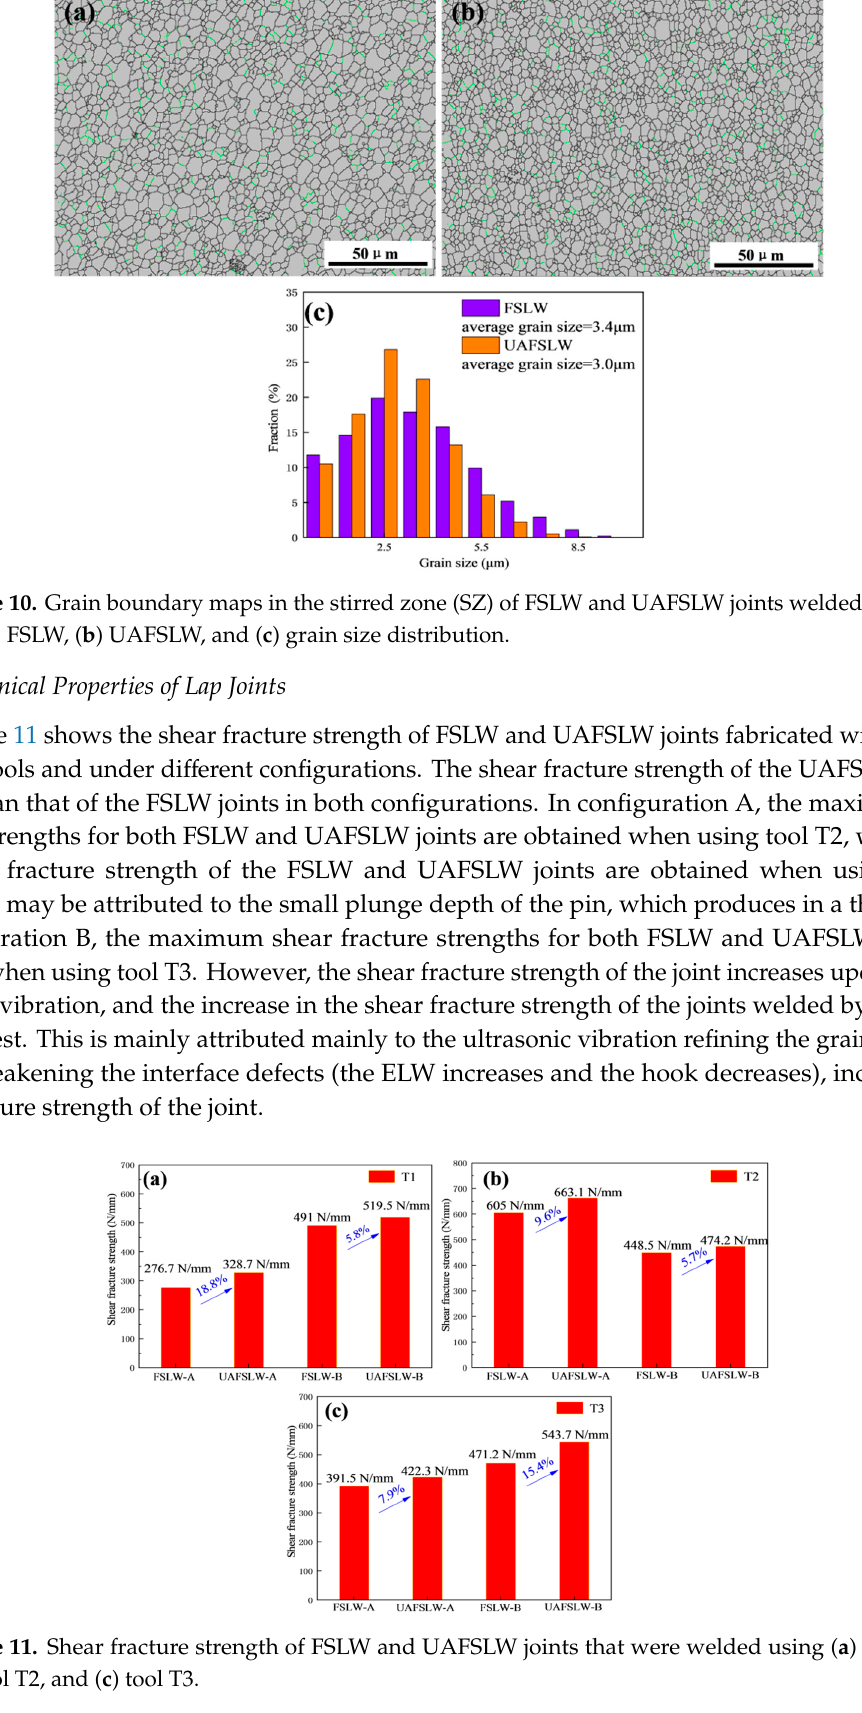
Figure 9. Microstructural images of the ( a ) base material, ( b ) heat-affected zone, ( c ) TMAZ on AS of the FSLW joint, ( d ) TMAZ on AS of the UAFSLW joint, ( e ) TMAZ on RS of the FSLW joint, and ( f ) TMAZ on RS of the UAFSLW joint.